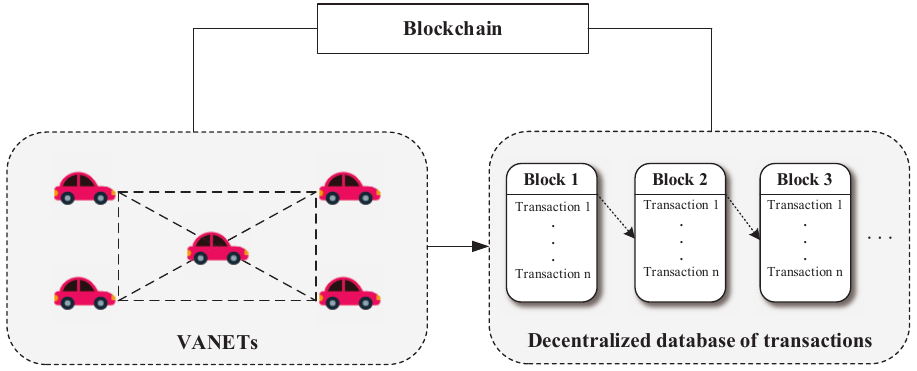
Figure 1. Blockchain Deployment in